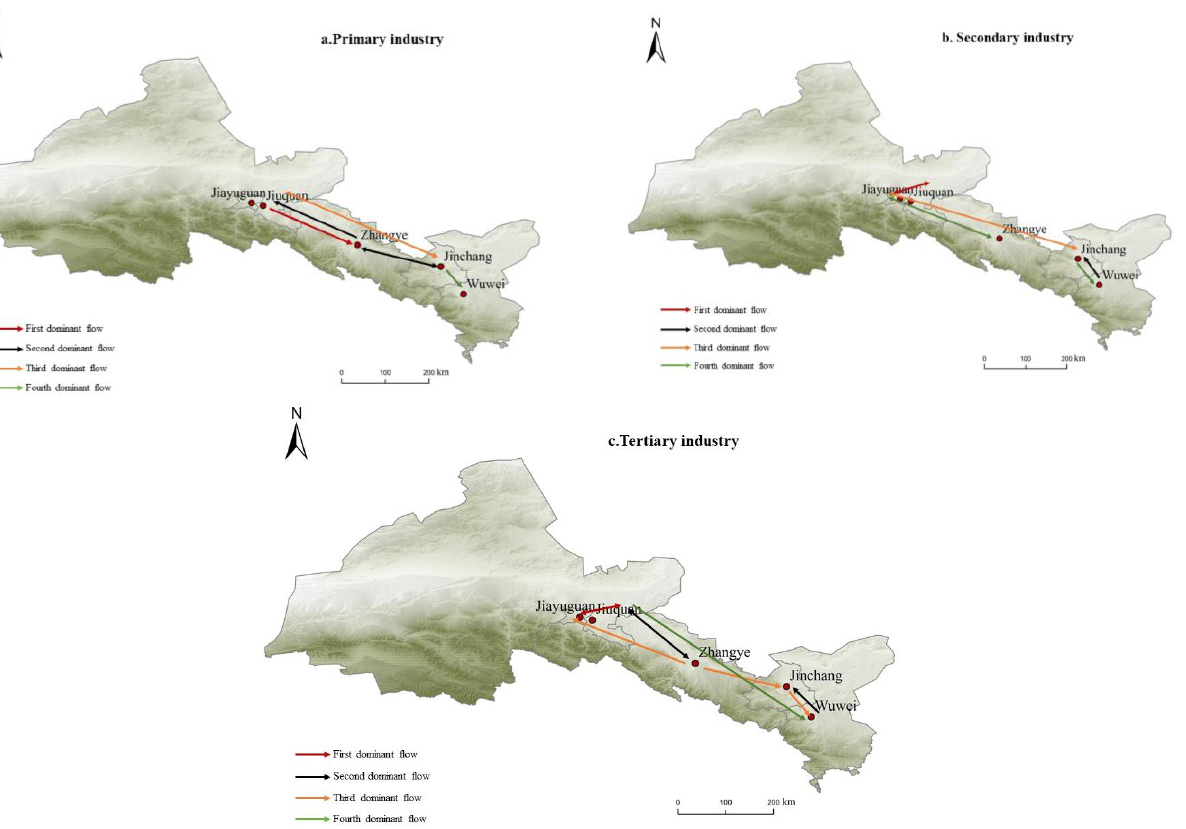
Figure 4. The advantageous flow direction of the “ three industries ” in the urban agglomeration in